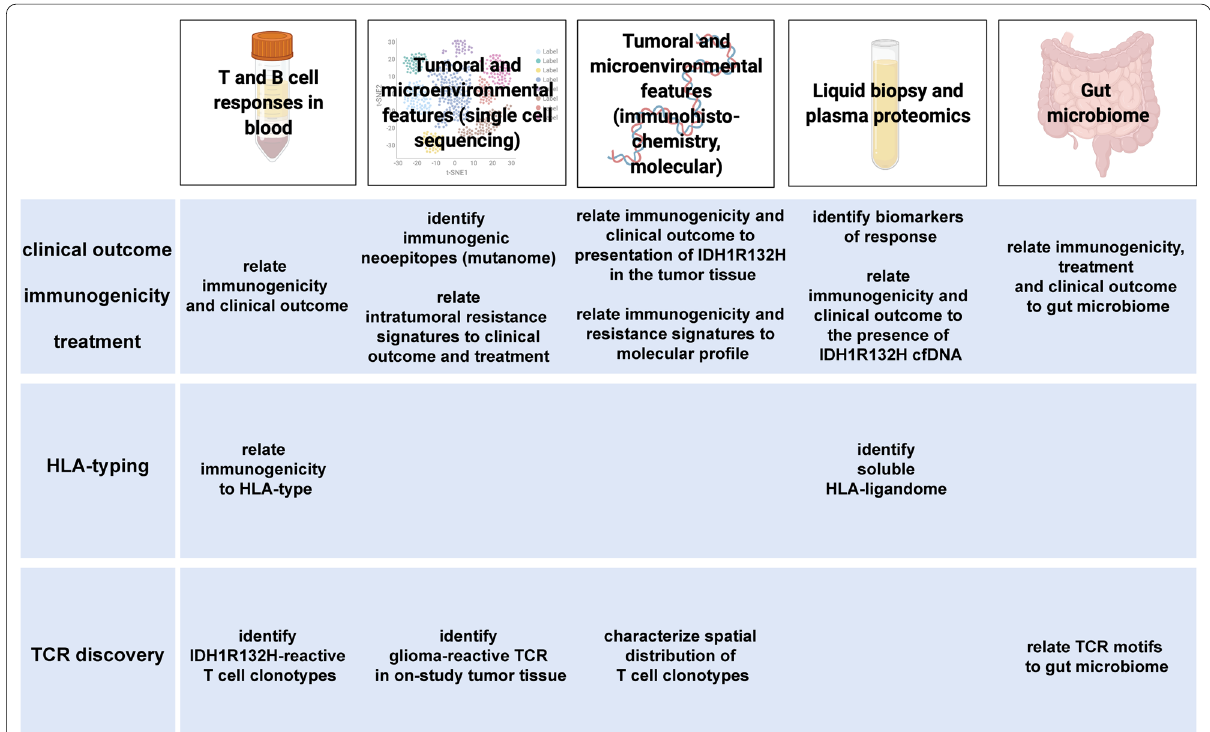
Fig. 2 Summary of exploratory analyses within AMPLIFY‑NEOVAC. T cell and B cell responses will be assessed as primary immunogenicity endpoints. Immunogenicity will be quantitatively and qualitatively correlated with supertype of human leukocyte antigens (HLA) and molecularly‑defined IDH1R132H‑specific T cells by single cell sequencing technologies. On‑trial tumor tissues will be dissociated and TIL will be subjected to single cell sequencing to identify and characterize glioma‑reactive T cells and treatment arm (1–3)‑specific microenvironmental reprogramming. Liquid biopsies and fecal samples will be subjected to proteomic and transcriptomic analyses, respectively, and correlated to immunogenicity data and clinical